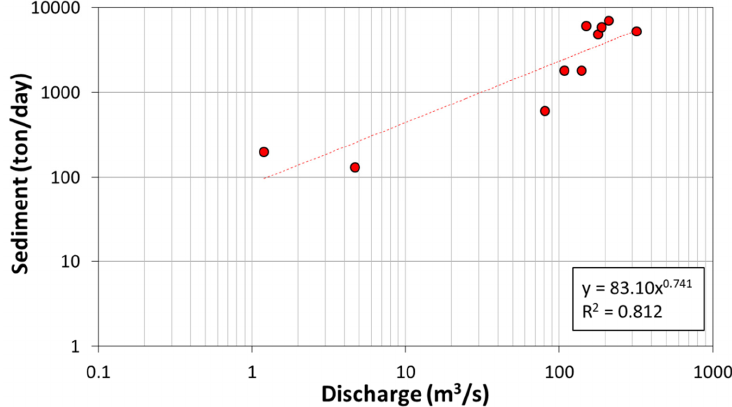
Figure 6. Sediment rating curve at study site of the Byeonseong river (Gyeongsangbuk-Do, 2011). The bed change of the 4 km target reach of the Byeongseong river surveyed in 2013 and 2014 was simulated with the measured inputs of stream flow and channel geomorphic terrain, as shown in Figure 7. The mesh comprised 13,365 nodes at a transverse interval of 20 m and a longitudinal interval of 10 m. For the simulation of the river bed change in the study area, the monitoring data were used twice in 2013 and 2014. The sedimentation pattern generally occurred at 4 km of the target section due to the change of the river bed for one year from 2013 to 2014, and sedimentation occurred at the end of the maximum curve and at the local part at the downstream, and erosion occurred inside the water culvert at 2 km, which was confirmed to have changed into a stable river bed without Water 2021 , 13 , 554 irregularities overall.